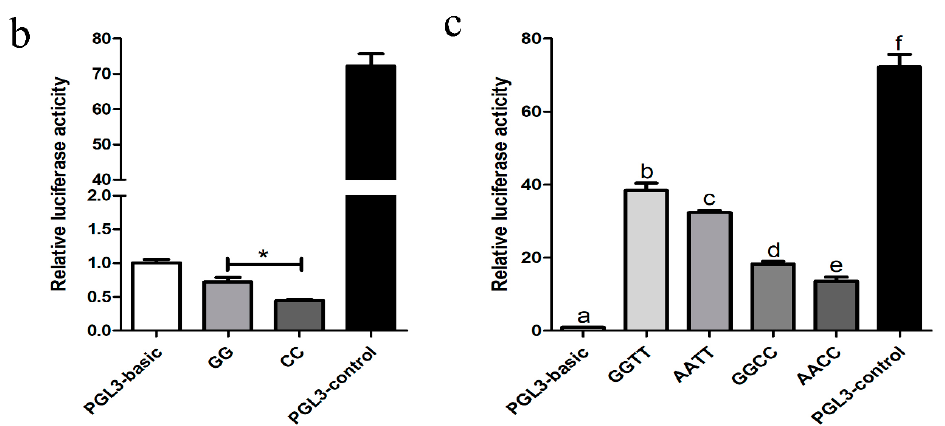
Figure 3. Luciferase assays for porcine HSD17B14 promoter activity analyses. The resulting firefly luciferase activity was normalized to Renilla luciferase activity and the relative values are presented as fold induction over the activity of the pGL3-basic vector. The basic activity value of positive control PGL3-basic was set as 1. PGL3-basic as a negative control and PGL3-control as a positive control. The relative luciferase activity values represent the mean ± SEM of three independent experiments. ( a ) Four luciferase reporter plasmids expressing successive truncations of the HSD17B14 promoter sequence were constructed and transfected into 293T cells. ( b ) Luciferase reporter gene assays of porcine HSD17B14 alleles containing rs342163057 ( − 850G > C). Two genotype luciferase reporter